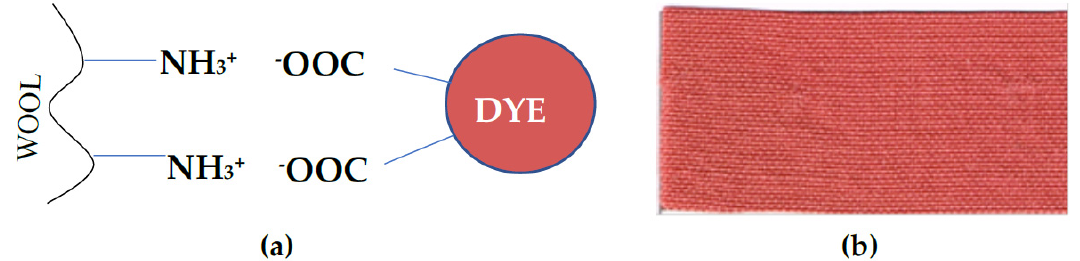
Figure 8. Scheme of dyeing mechanism ( a ) and sample of wool fabric dyed with 1% of AB2 compound ( b ), tested under dyeing quality. Table 4. Colour fastness of wool fabric dyed with the AB2 dye at a concentration of 1%. Tested Parameters of Colour